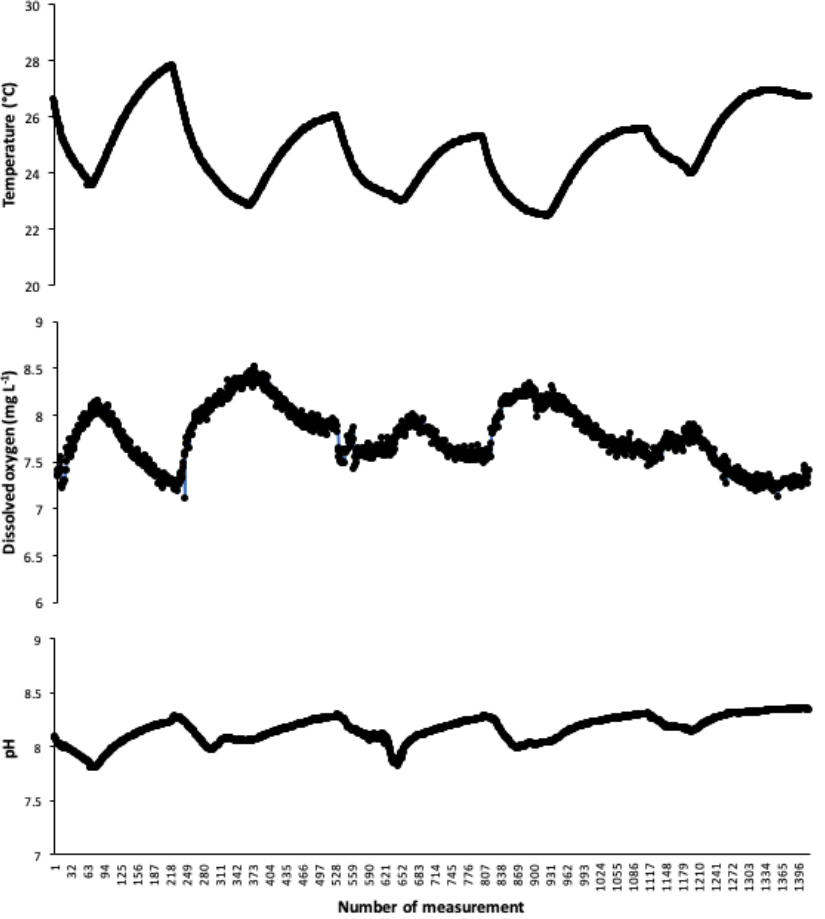
Figure 8. Behavior of the proposed low-cost system over the test time. Table 4. Reliability (precision, accuracy, and sensibility) of the proposed low-cost water-quality system ( σ is standard deviation and C.V. coe ffi cient of